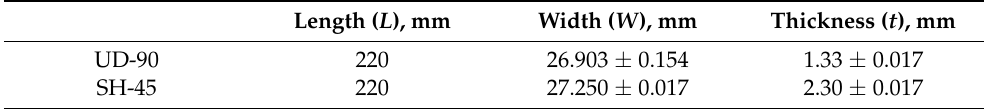
Table 3. Dimensions of the additively manufactured specimens.